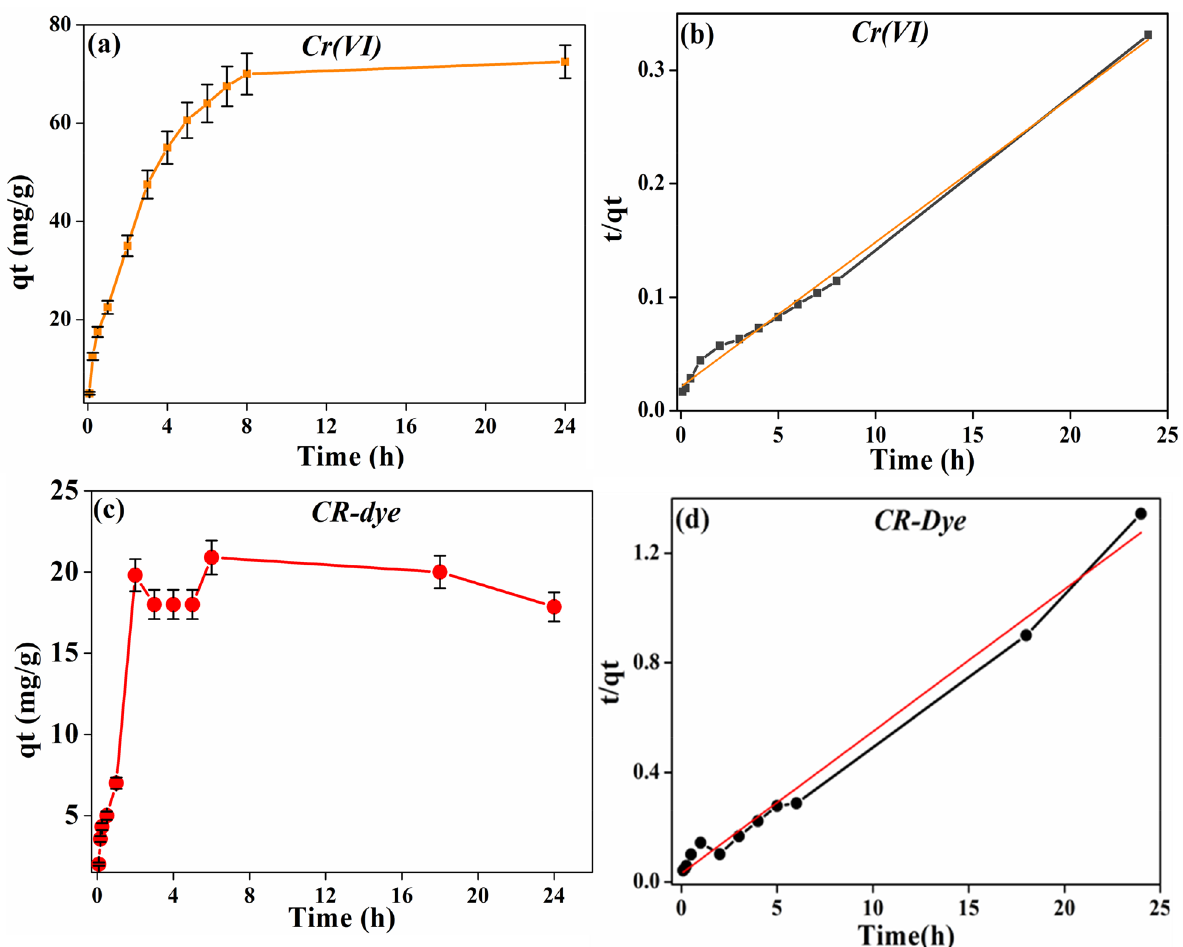
Figure 6. Adsorption kinetics of Cr(VI), and CR-dye on the prepared PMC based material. ( a ) Time study of Cr(VI), ( b ) pseudo-second-order kinetic model of Cr(VI), ( c ) time study of CR-Dye, and ( d ) pseudo-second- order kinetic model of respectively. The adsorption capacity reached equilibrium with increasing aqueous phase concentrations. The Langmuir and Freundlich isotherm was used in the linearized form to fit the equilibrium data: